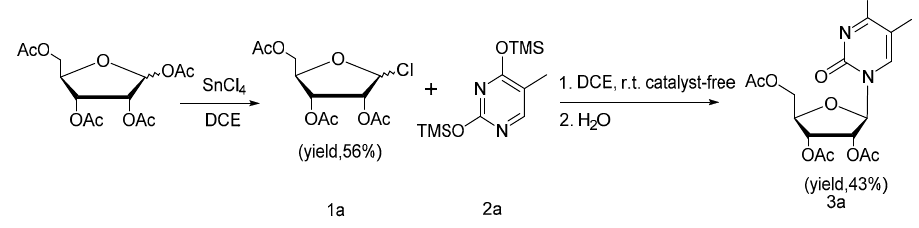
Figure 6. Verification of speculated path b of silyl-Hilbert-Johnson reaction.